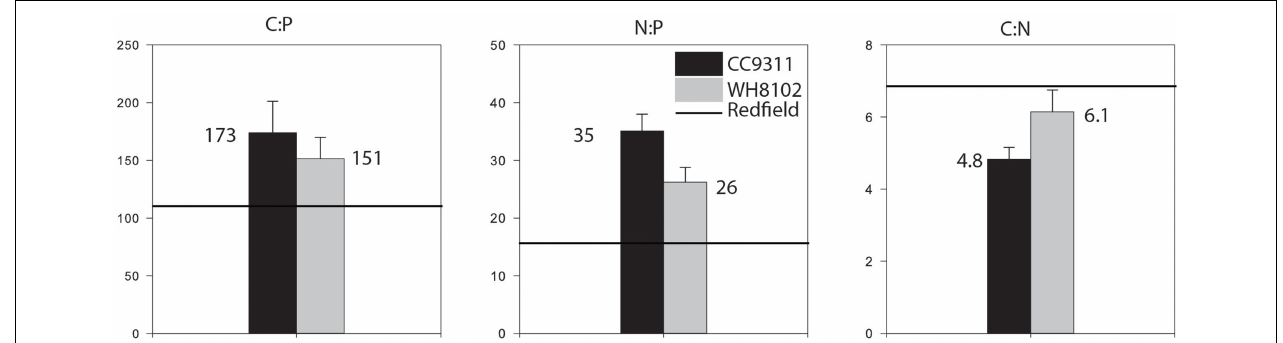
(Mann–Whitney rank sum test, P > 0 . 05). C:P and N:P ratios were greater than Redfield (Wilcoxon signed rank test, P < 0 . 001). C:N for Synechococcus